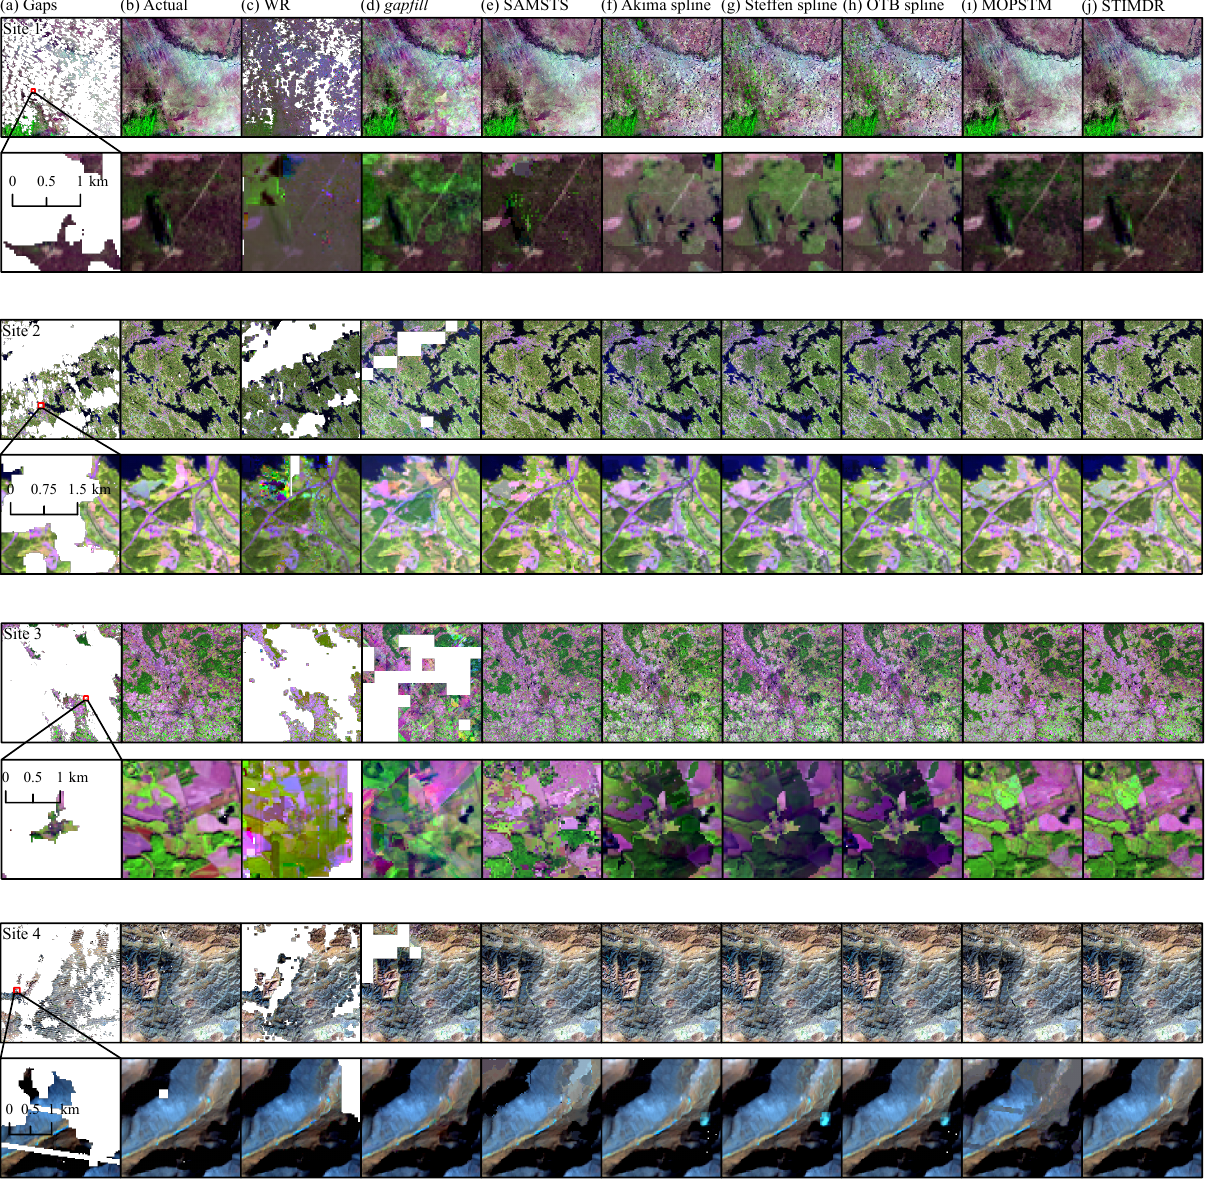
Figure 5. Results of gap-filled images using different methods in the four sites, acquired on 9 March 2017, 21 August 2015, 12 October 2018, and 10 December 2014, respectively, displayed in false color of R: SWIR1, G: NIR, and B: red surface reflectance: ( a ) Target images with simulated gaps, ( b ) referenced image and the results of ( c ) WR, ( d ) gapfill , ( e ) SAMSTS, ( f ) Akima spline, ( g ) Steffen spline, ( h ) OTB spline, ( i ) MOPSTM, and ( j ) STIMDR. Each image size is 2000 × 2000 30 m pixels, resulting in 60 km × 60 km. The valid pixel percentages were 37.3% (Site 1), 39.3% (Site 2), 15.3% (Site 3), and 26.4% (Site 4). Missing data are shown in the white